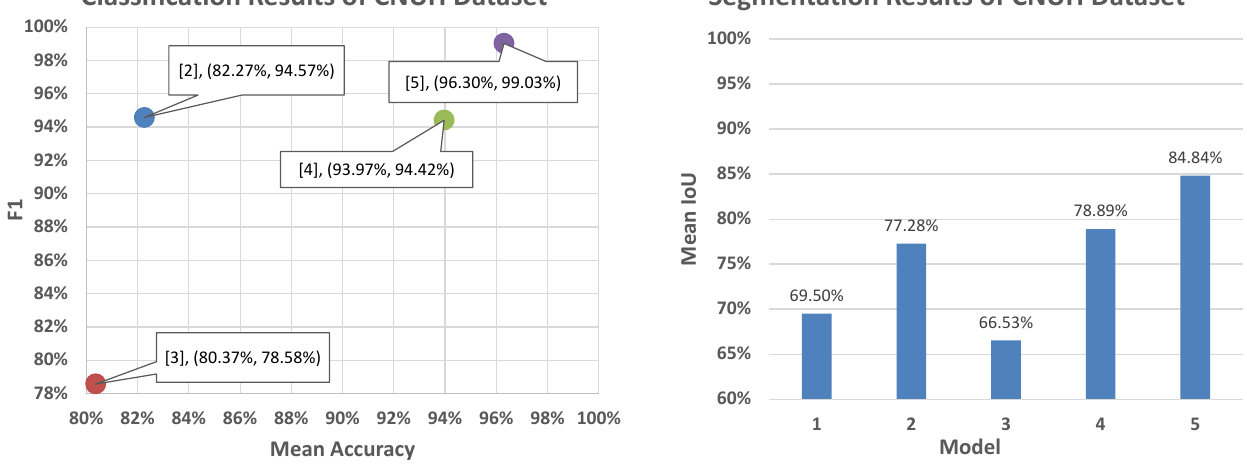
Figure 15. Classification and segmentation performance in the CNUH validation set. In this study, the multi-level distance feature map served as an attention map to help our model detect small tumors. They provided the probability of background region, tumor region, and neighbouring regions around tumors. From there, the tumors can be recognized based on the pixel-level features of the neighbouring regions in difficult cases with very small tumors in high-resolution images. The background region feature map shown in Figure 10 illustrates the efficiency of learning the multi-level distance feature. It shows four rectangles corresponding to the four distance levels from distances 0 (at tumor), 0.25, 0.5 and 0.75 according to the ratio of image